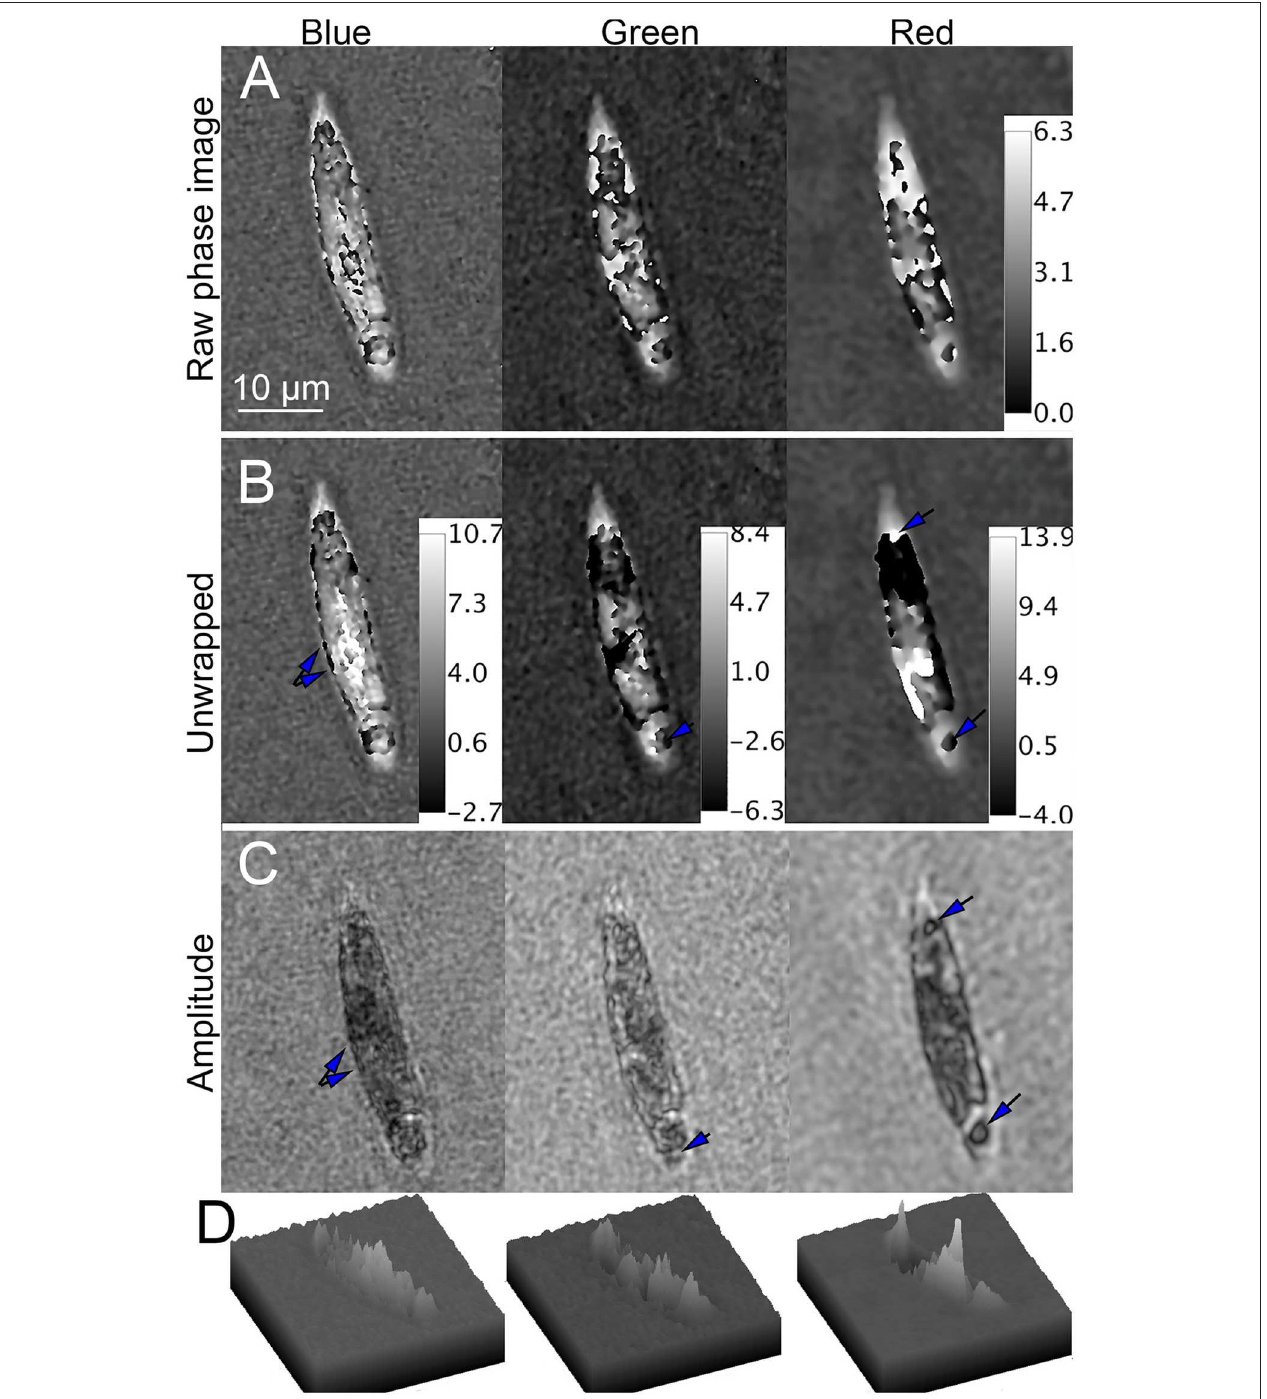
FIGURE 10 | Phase unwrapping of streptomycin bleached Euglena in three wavelengths. Phase scale bars are in radians. The spatial scale bar applies to all panels. (A) Raw phase image showing decreasing wrapping with increasing wavelength. (B) Unwrapped phase images compared with (C) amplitude image. In the blue (Left), there are multiple small features on the edges of the cell apparent in both amplitude and phase (arrows). In green (Center), large areas of the cell that appear transparent in amplitude are dark in phase. In red (Right), areas of both positive and negative contrast are seen (arrows), with large areas of positive phase contrast corresponding to dark areas in amplitude and negative contrast corresponding to transparent areas in amplitude. (D) Surface plot of phase shifts in blue (left), green (center), and red (right).